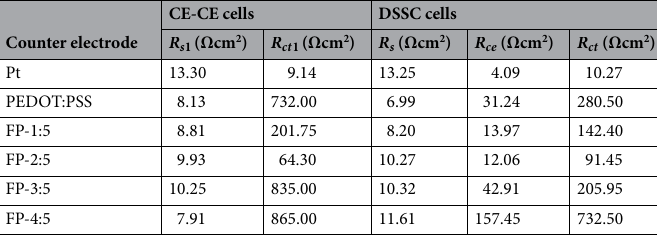
Table 2. Summary of the electrochemical parameters of prepared